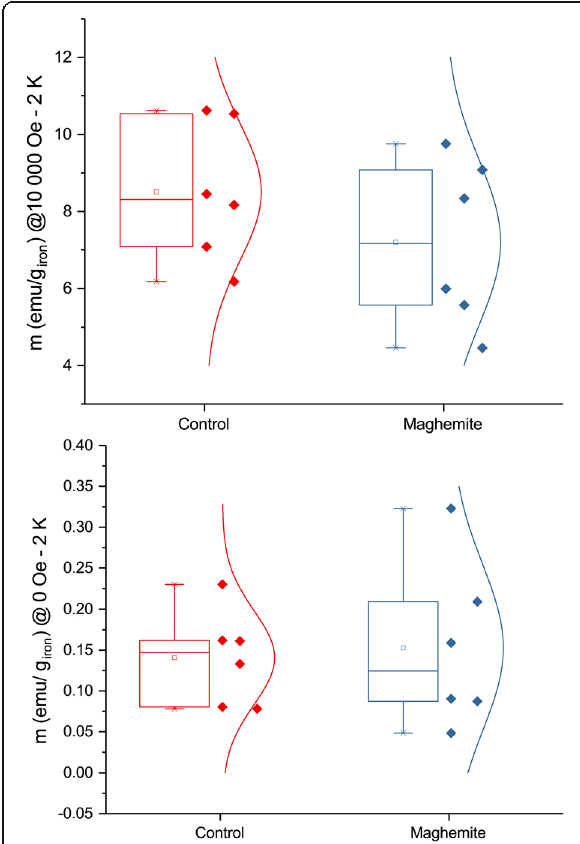
Fig. 9 Low-temperature (2 K) magnetization of ashed leaves under different magnetic fields. The plot above at 10000 Oe have a p value of 0.8, and the plot below at zero field has a p value of 0.08 ( n =